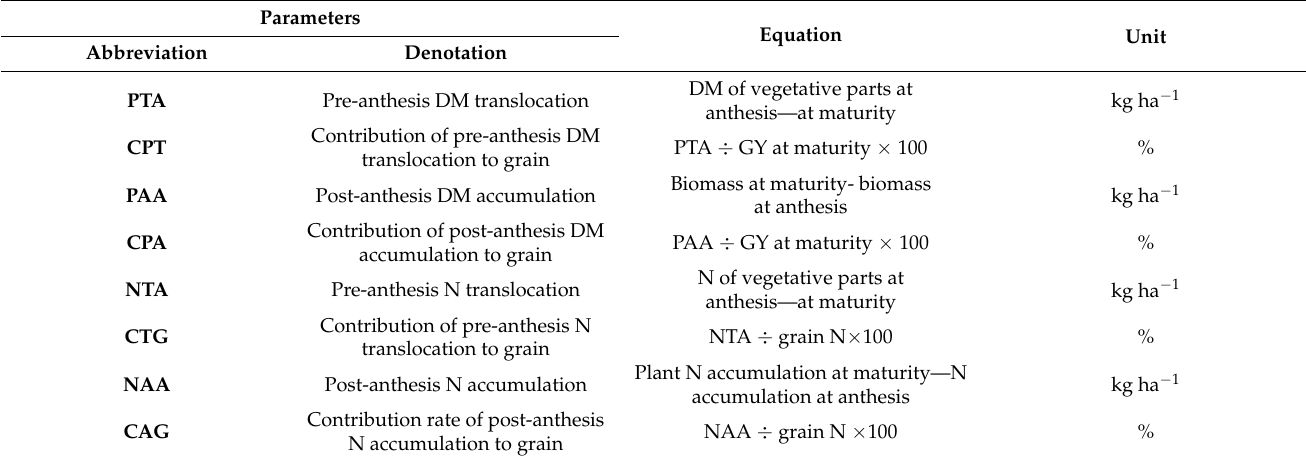
Table 8. Equations for estimating dry matter and nitrogen translocation.